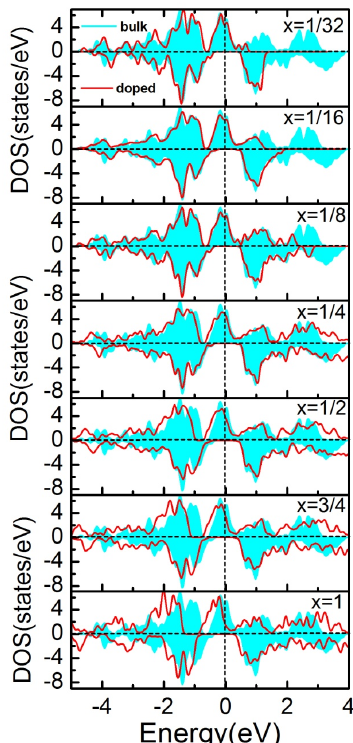
Figure 1. Total density of states (DOS) of the ordered TiZrCoIn quaternary Heusler alloy (shadowed area) and the doped systems (solid line). Note that all DOS are transited to a primitive cell. Notice that x in the figure is the doping concentration.